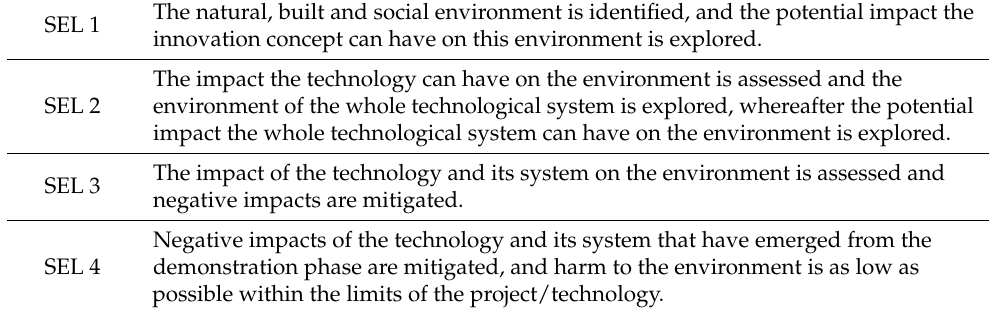
Table 4. Dimension 1: impact on the